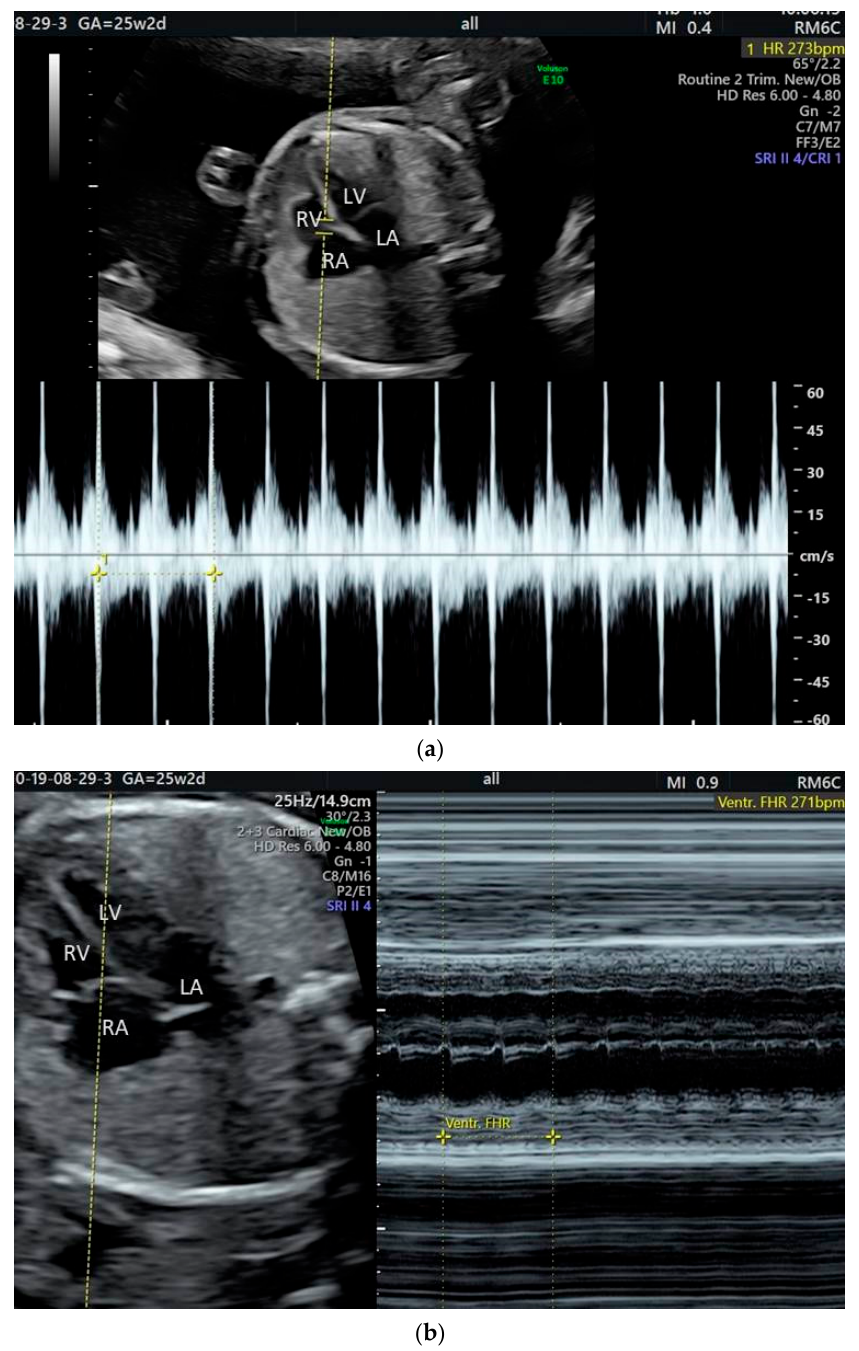
Figure 4. Fetal supraventricular tachycardia: ( a ) Pulsed Doppler analysis; ( b ) M-mode analysis.